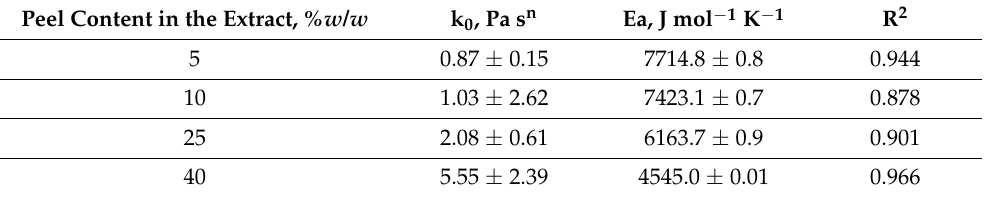
Table 2. Arrhenius model for consistency coefficient of passion fruit peel extracts. Peel Content in the Extract,